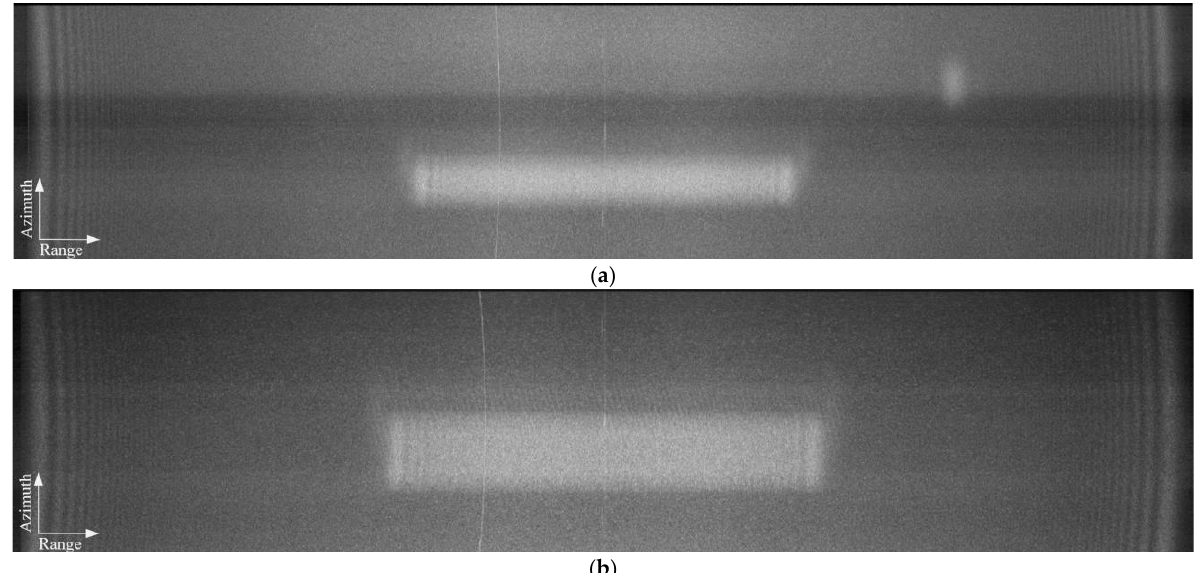
Figure 11. The 2-D range spectrums of the WBI-contaminated SLC data. ( a , b ) The 2-D range spectrums of scene 1 and scene 2,